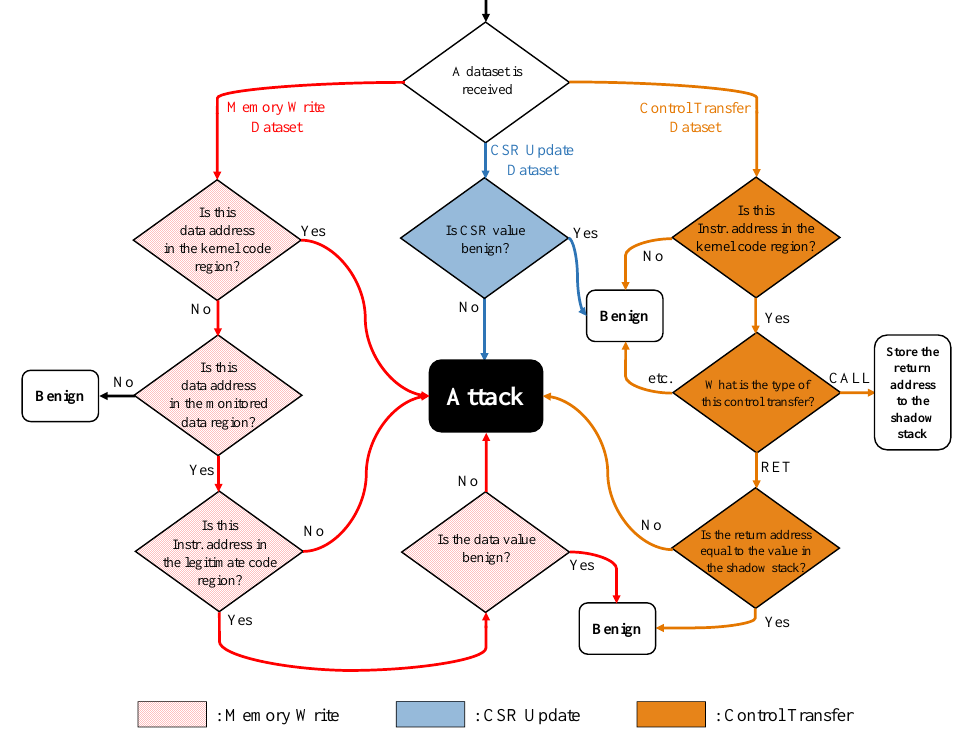
Figure 3. The Flowchart of RiskiM